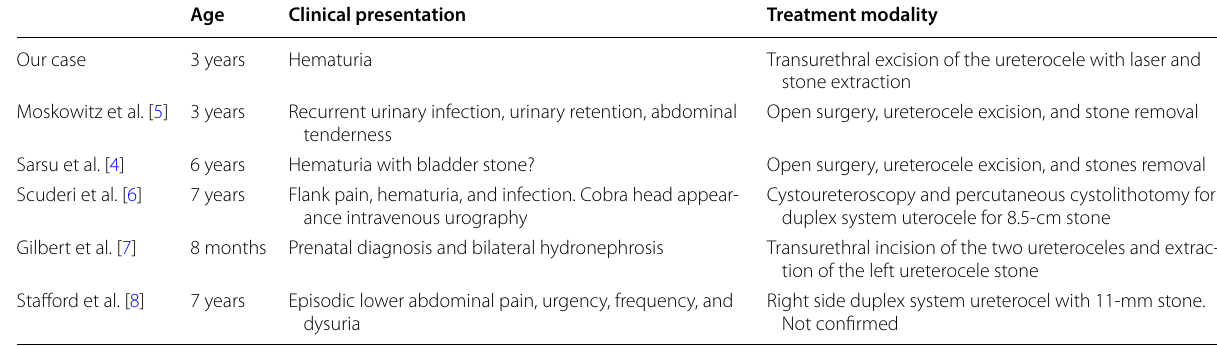
Table 1 Clinical presentation and treatment modality of the reported cases in